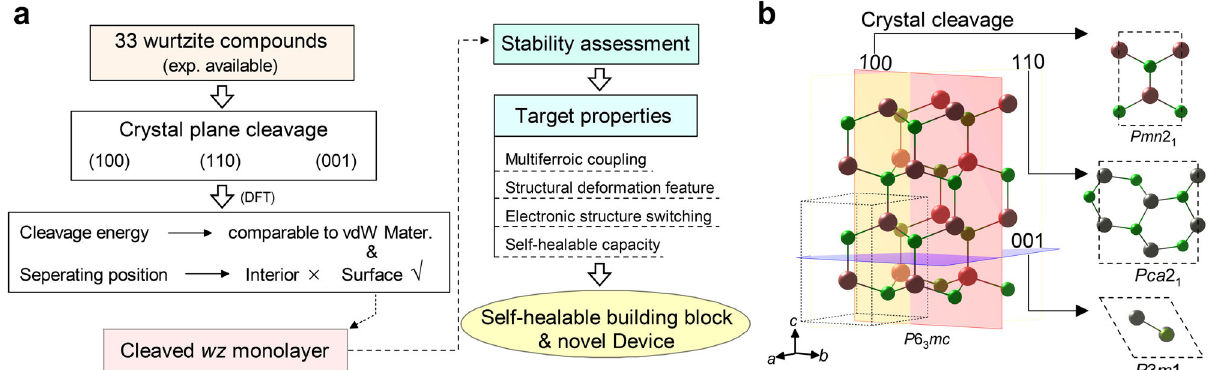
Fig. 1 Screening scheme for wz monolayer. a The material research framework combined with multiferroic, electronic structure, and fl exible feature evaluation to screen wz monolayers with potential application in fl exible device. The electronic and stability properties of these screened candidates are further calculated using DFT. b Cleavage of the three typical plane (100), (110), and (001) for the wz crystal to form the monolayer